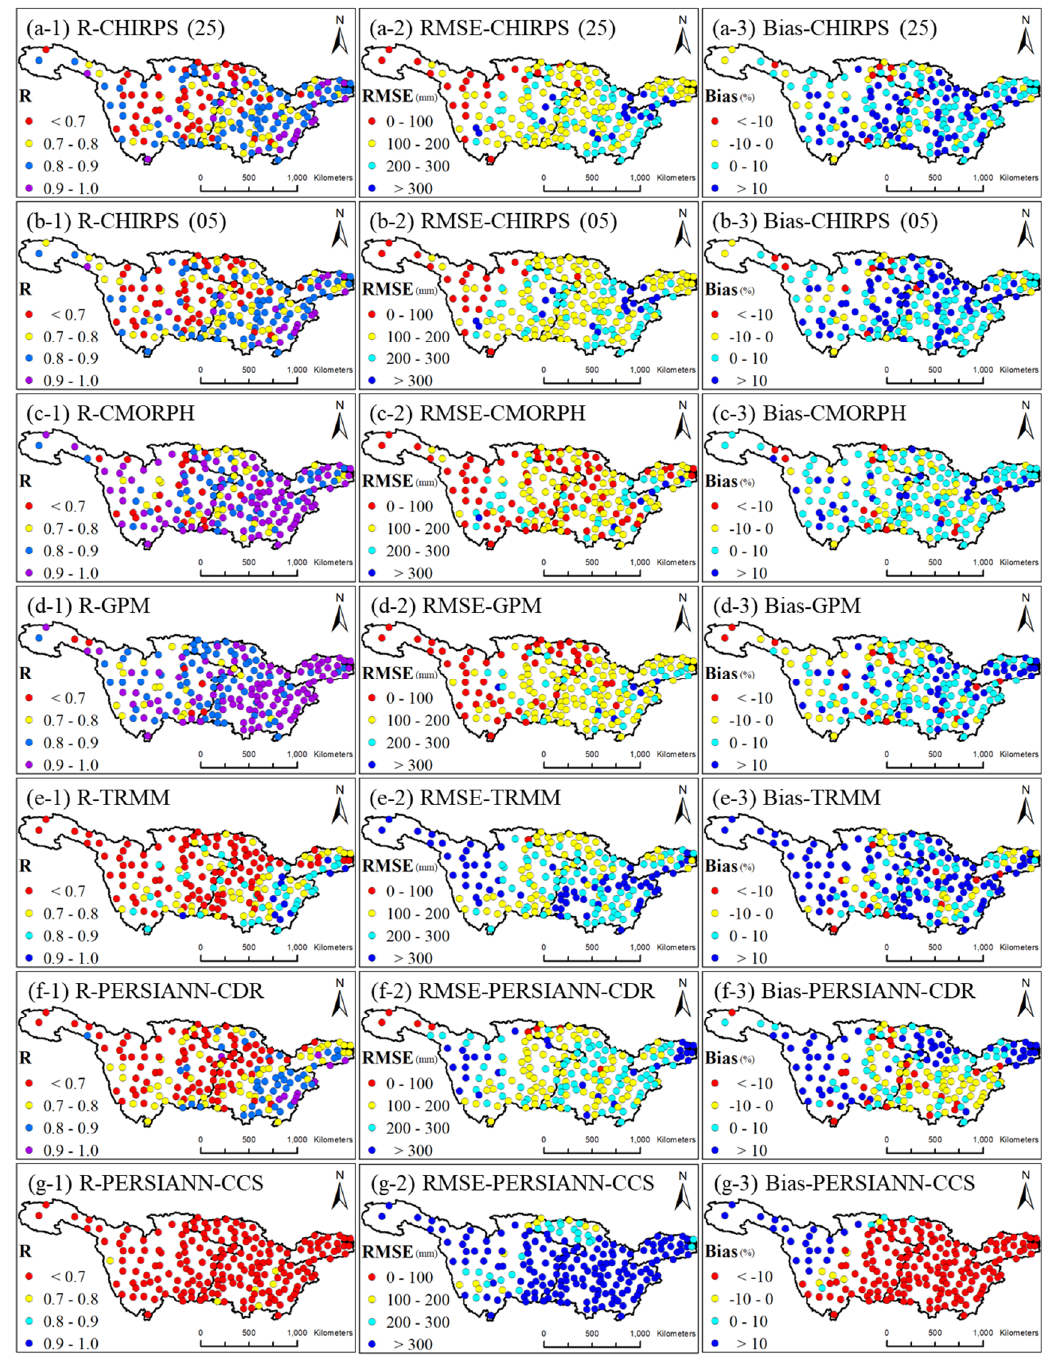
Figure A2. The spatial distribution of the R , RMSE , and Bias of SPPs on the annual scale.